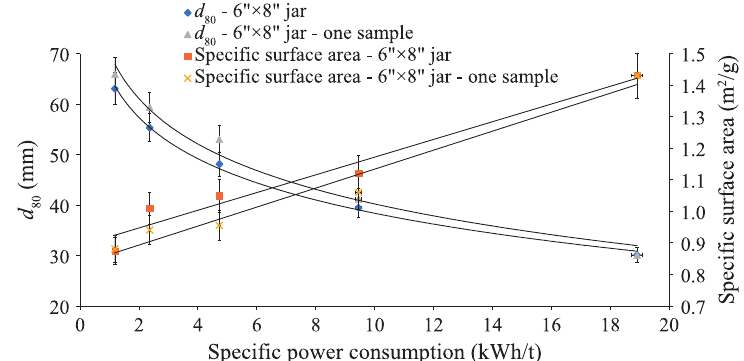
Fig. 9 Specific power consumption as a function of d 80 and specific surface area—one sample per